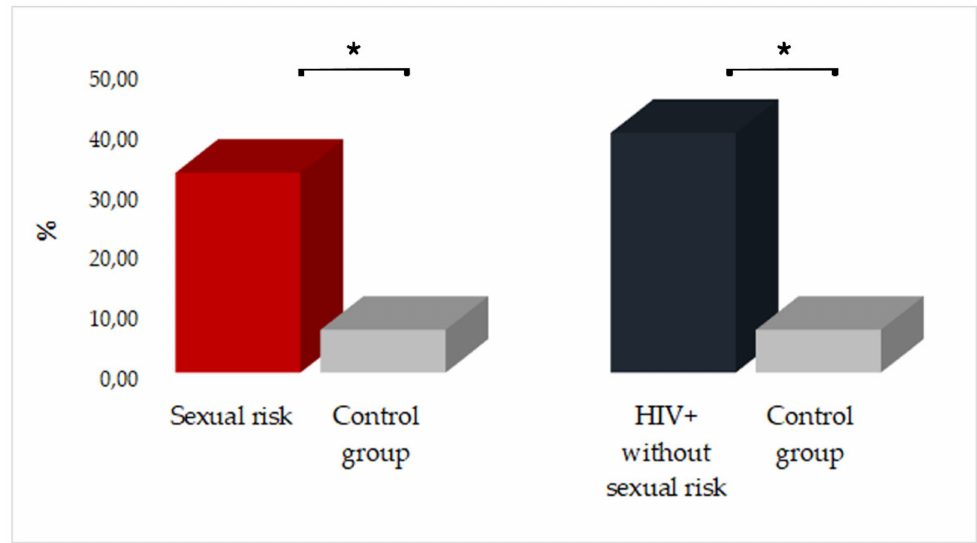
Figure 3. Assessment of SRBs (SRB group and HIV+ subjects with SRBs) and HIV-positivity as factors promoting HPV-infection (* = p < 0.05).